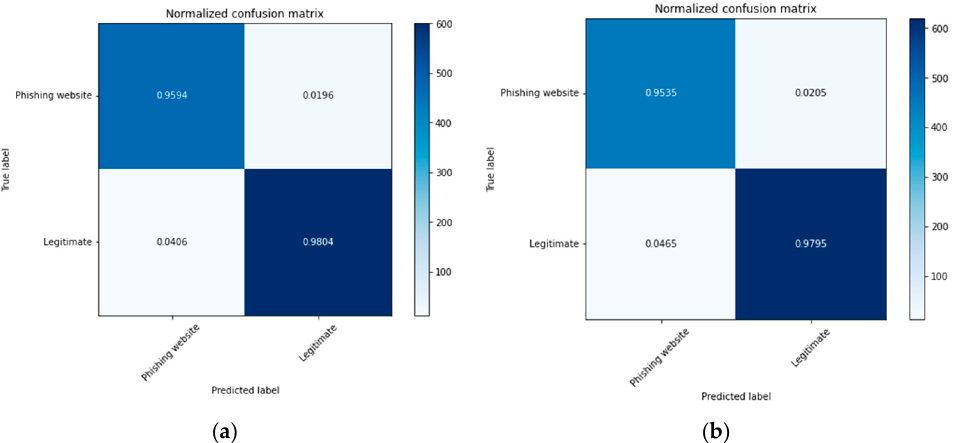
( a ) ( b ) Figure 6. A normalized confusion matrix of XGBoost for phishing website and legitimate website classification: ( a ) with default parameters; ( b ) with optimized parameters for Dataset 1.